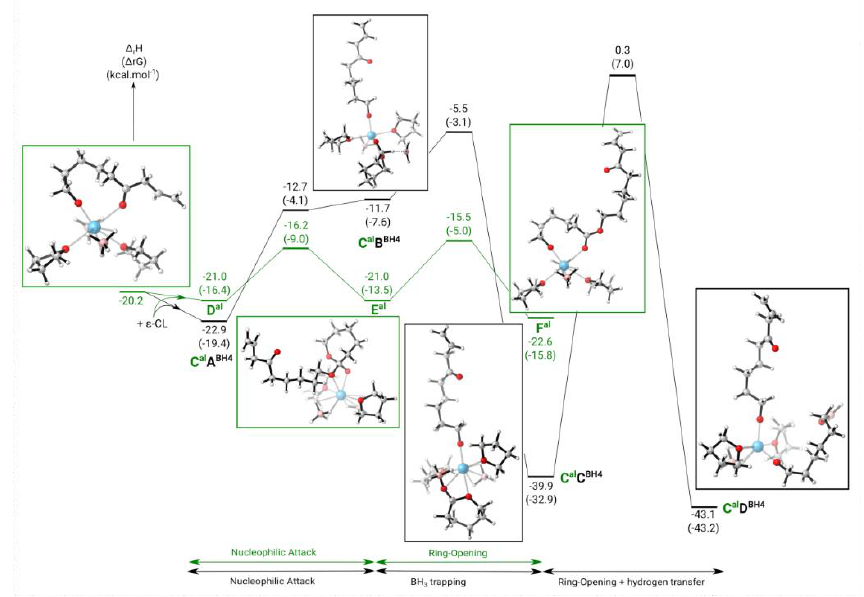
Figure 2. Calculated enthalpy profiles of the first propagation step in the ROP of ε-CL mediated by the allyl group (green lines) or the borohydride group (black lines) of La(BH 4 ) 2 (OC 5 H 10 COC 3 H 5 )(THF) 2 .